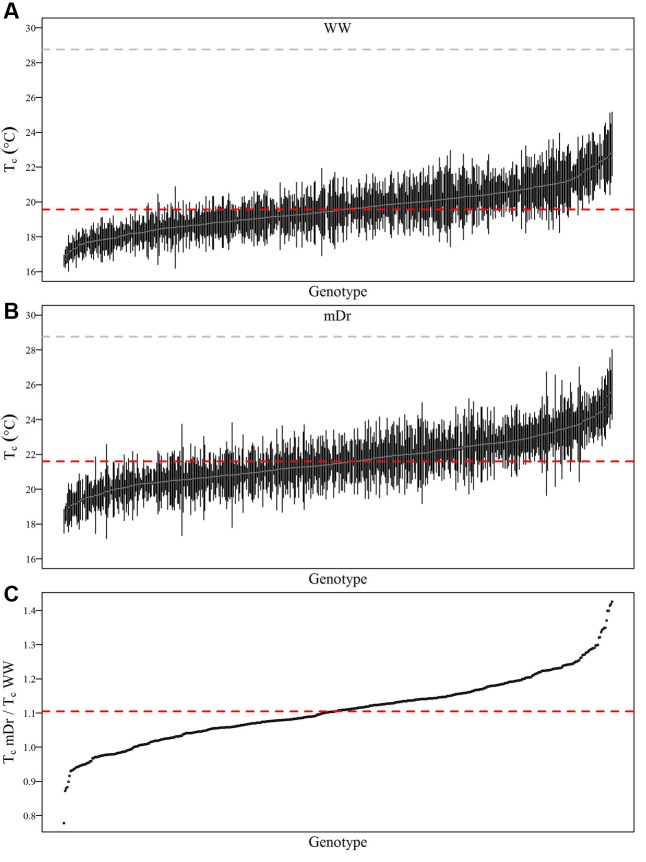
Average Tc (°C) for each genotype in WW and mDr. (A) Genotypic mean Tc (gray circles) and standard error (black bars) in WW conditions. (B) Genotypic mean Tc (gray circles) and standard error (black bars) in mDr conditions. (C) Ratio of TcmDr to TcWW (black circles). Genotypes in (A,B) are ordered based on increasing Tc. Genotypes in (C) are ordered based on increasing ratios. The dashed gray line and dashed red lines in (A,B) show Ta during the unmanned aerial vehicle (UAV) flights and population averaged Tc, respectively. The dashed red line in (C) displays population averaged TcmDr/TcWW. A total number of 503 genotypes is shown in (A–C).